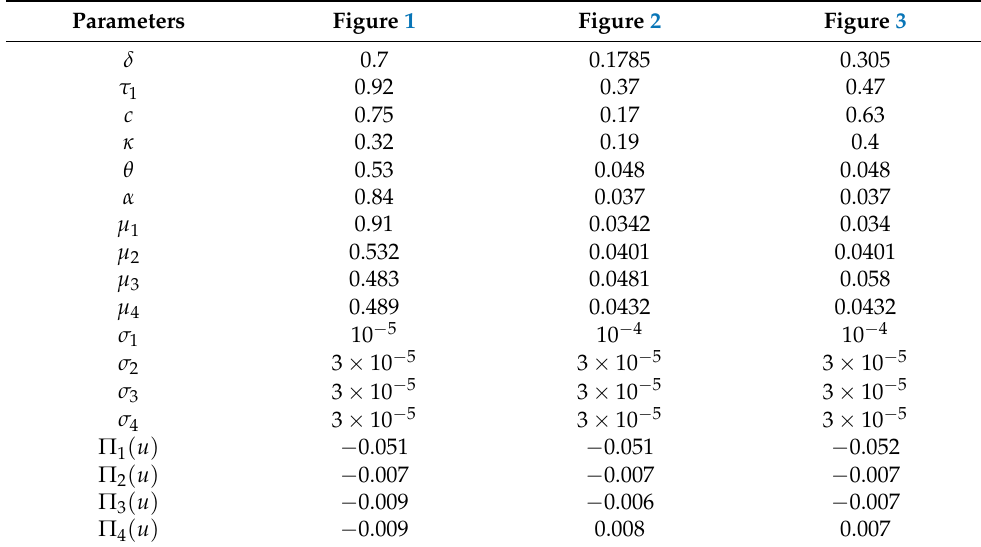
Table 1. The values of the used parameters.